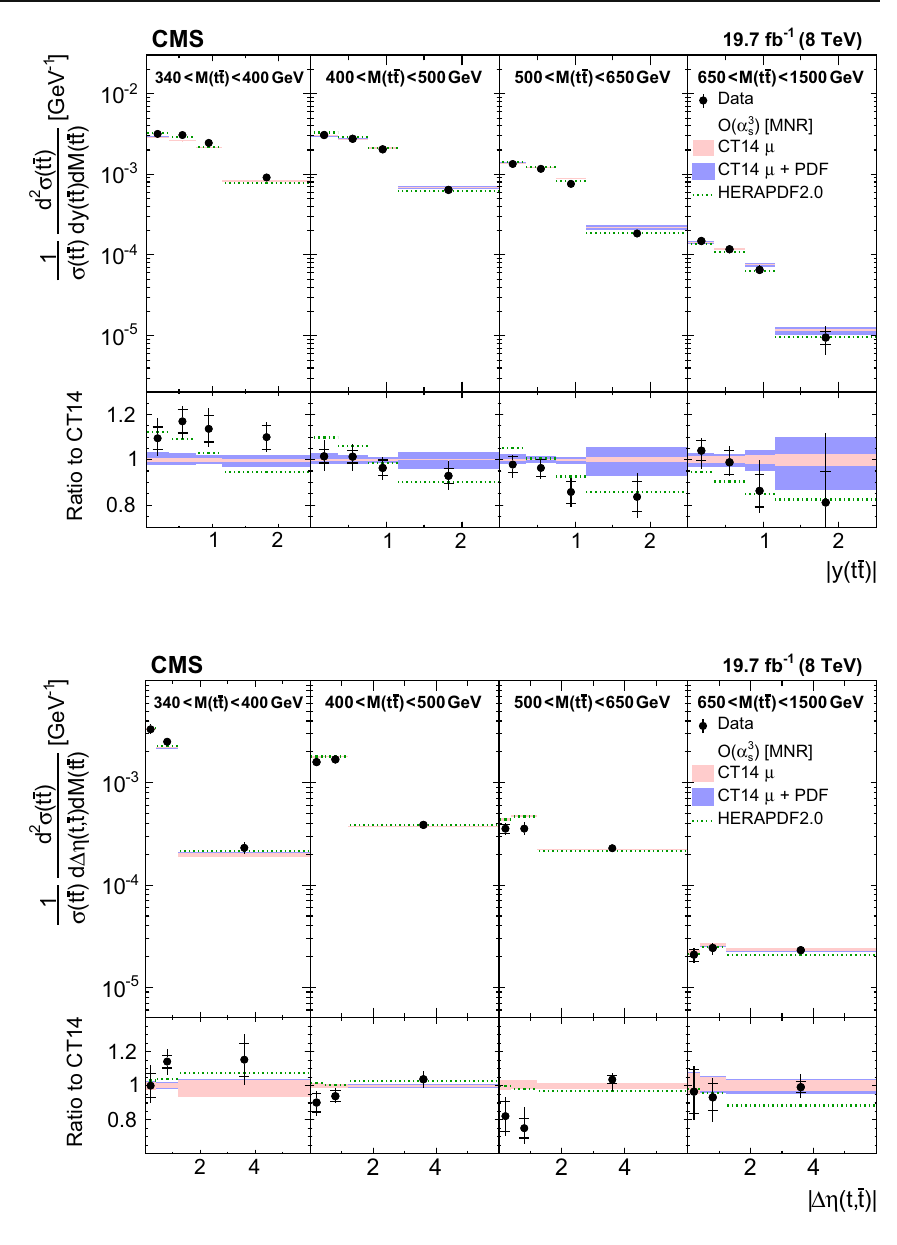
Fig. 10 Comparison of the measured normalized tt double-differential cross section as a function of | y ( tt ) | in different M ( tt ) ranges to NLO O (α 3 s ) predictions. Details can be found in the caption of Fig. 8. Approximate NNLO O (α 4 s ) predictions are not available for this cross section